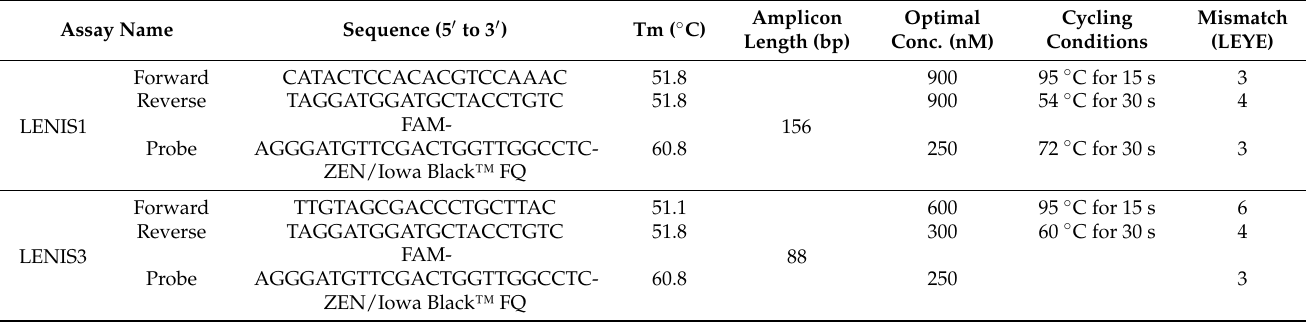
Table 2. Candidate qPCR assays (forward primer, reverse primer, and hydrolysis probe) developed and used for detection of L. nivalis . Assay-specific information also includes optimal primer and probe concentrations, thermocycling conditions, and mean number of mismatches to a closely related congener, L. yerbabuenae